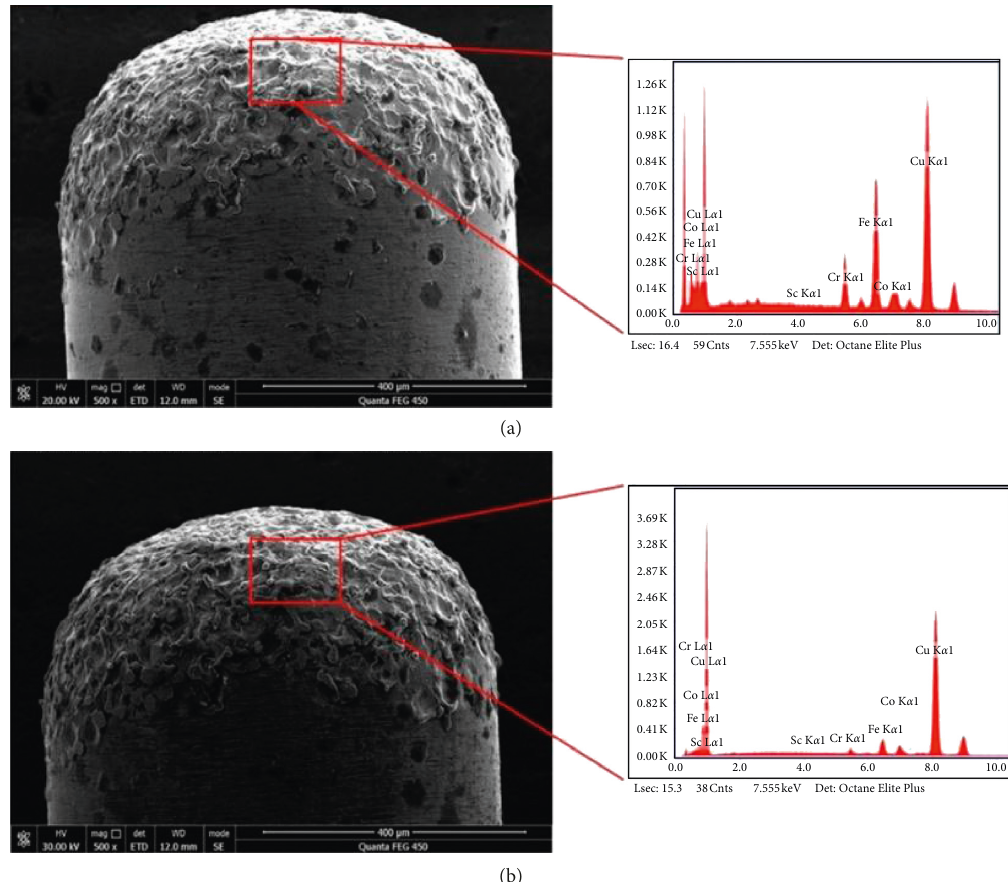
Figure 14: EDX analysis of the top surface of the electrode: (a) EDM oil; (b) EDM oil mixed with 10g/L Al